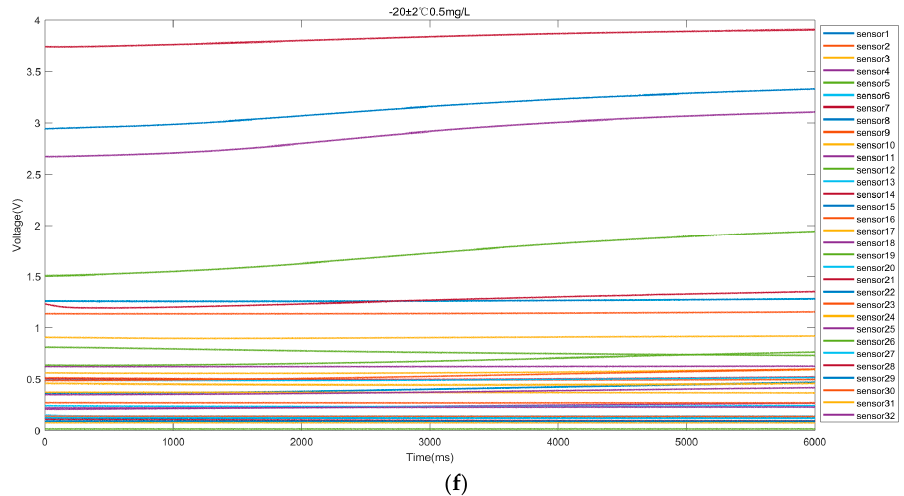
Figure 3. ( a ) (20 ± 2) °C 0.1mg/L sensor response; ( b ) (20 ± 2) °C 0.5 mg/L sensor response; ( c ) ( − 10 ±